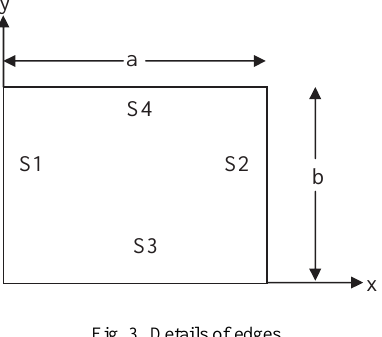
Fig. 3. Details of